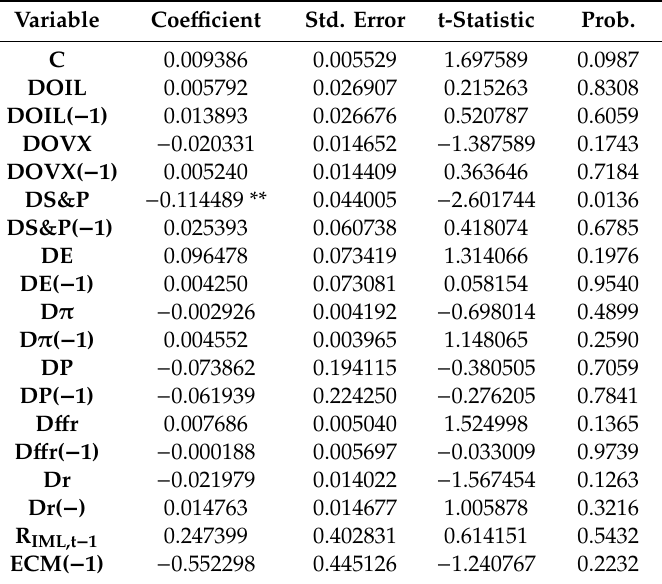
Table 19. Short-run error correction model (financial crisis).